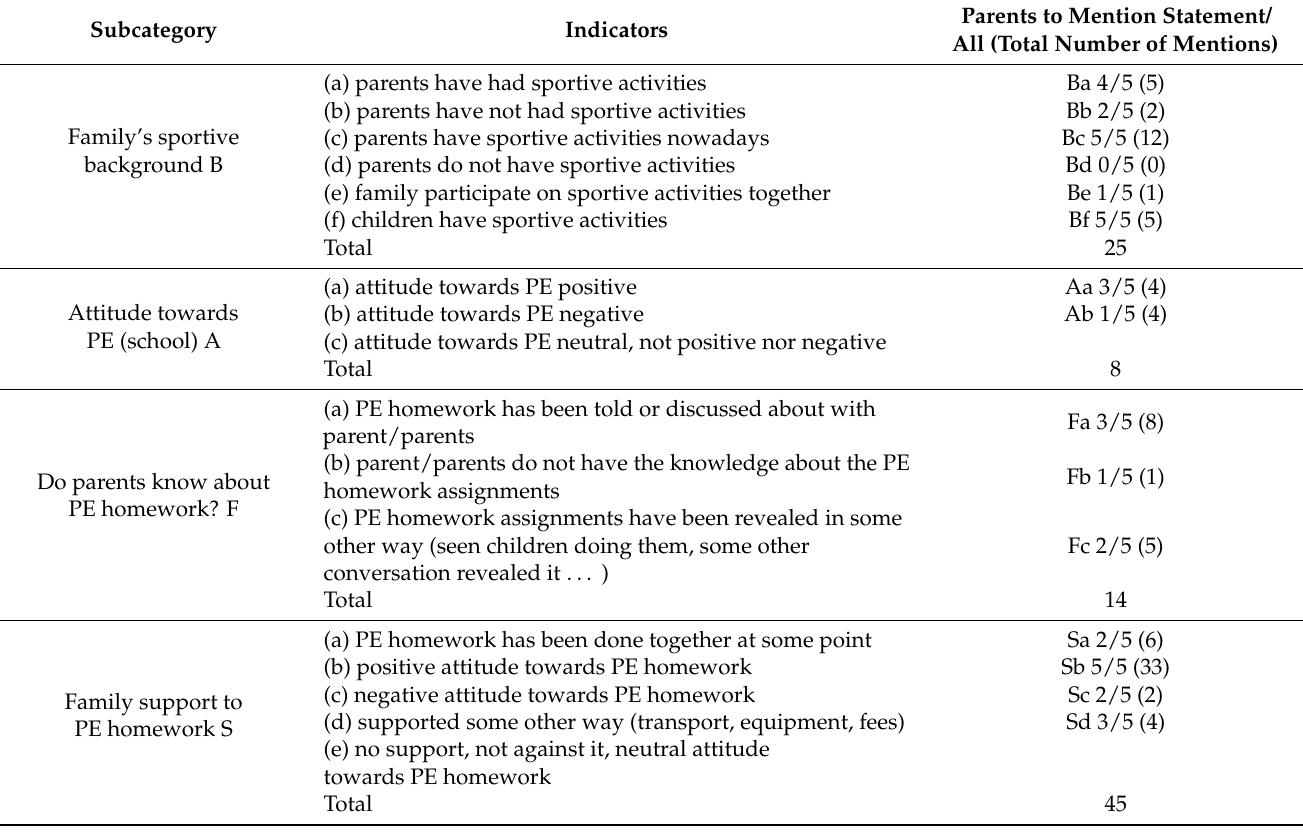
Table 2. The analysis summary of parents’ interviews (N =